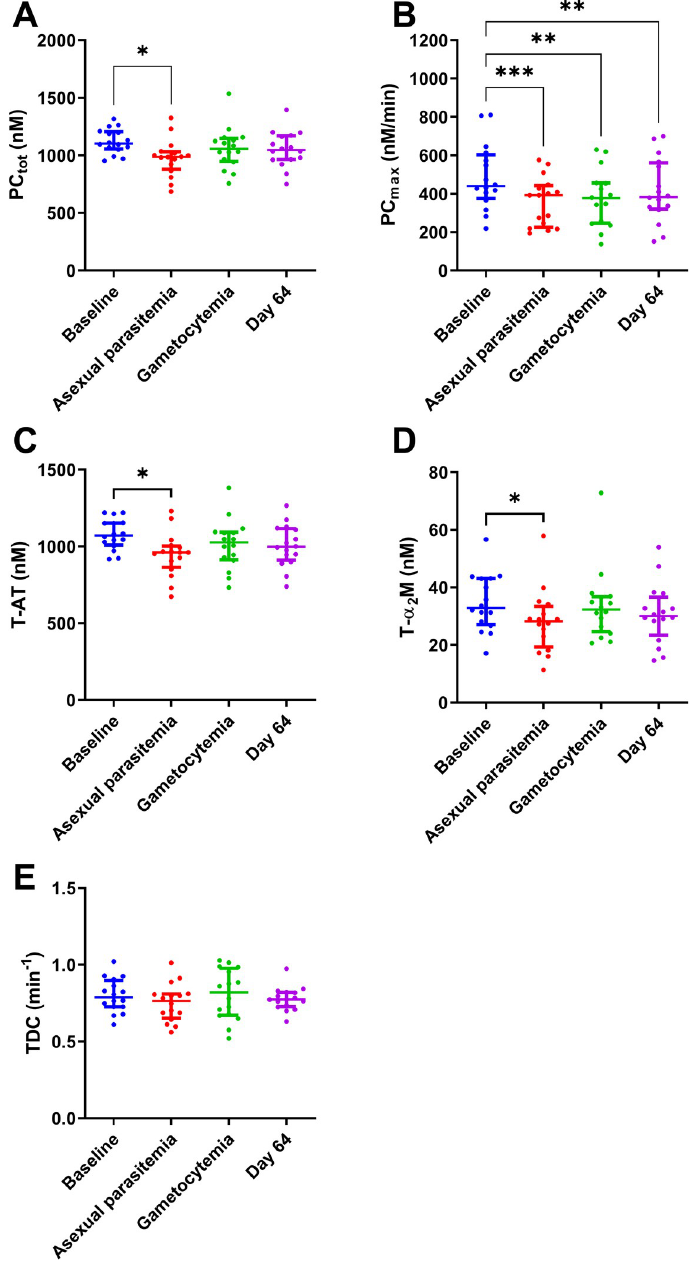
Fig 5. Thrombin dynamics analysis in the four stages of plasmodium falciparum infection. (A) The total amount of converted prothrombin(PC tot ) is decreased during asexual parasitemia. (B) The maximum rate of prothrombin conversion (PC max ) is decreased during asexual parasitemia. (C-D) Thrombin-antithrombin complex(T-AT) and Thrombin- α 2 M complex (T- α 2 M) formation are decreased during asexual parasitemia. (E) The thrombin decay capacity (TDC) remained unchanged. Results are shown as the median and interquartile range, and � , �� and ��� indicate p-values below 0.05, 0.01, and 0.001,